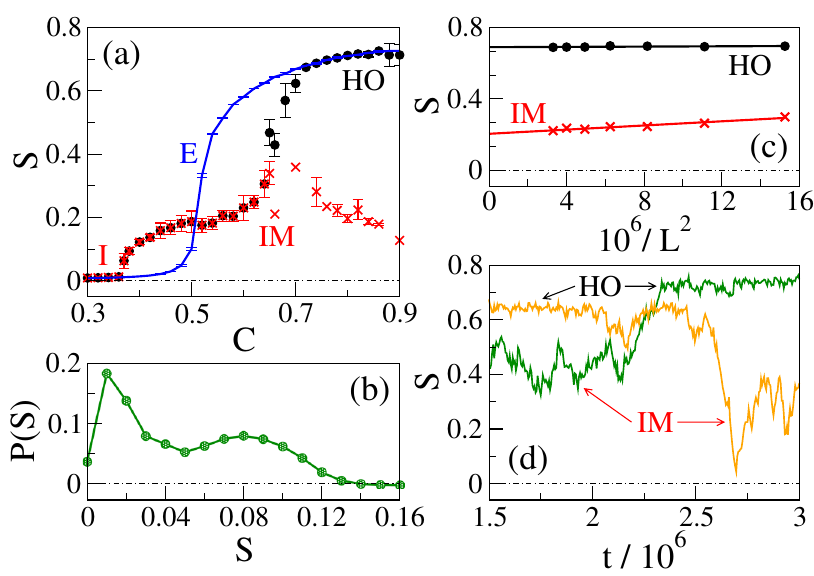
Figure 2. Disorder - order transition. ( a ) Scalar order parameter versus packing density plot for 400 × 400 system size at βε = 2.0. The equilibrium system (E, solid line) shows continuous isotropic to nematic state transition with increasing density. The active system goes from the isotropic (I) state to the locally ordered inhomogeneous mixed (IM, × ) state. In the high density regime, the system shows bistability between the IM state and the homogeneous globally ordered (HO, • ) state. ( b ) The I to IM transition at low temperature occurs with a jump in S where the particles form bands (BS). Distribution of the scalar order parameter near the I - BS transition at ( βε , C ) = (2.0, 0.37) shows two peaks. ( c ) Finite size scaling of S for both the HO and the IM state at ( βε , C ) = (2.0, 0.76). ( d ) Order parameter time series show that the active system flips in between the HO and the IM state in the bistable regime. Two time series are shown for two different parameter values in the high density